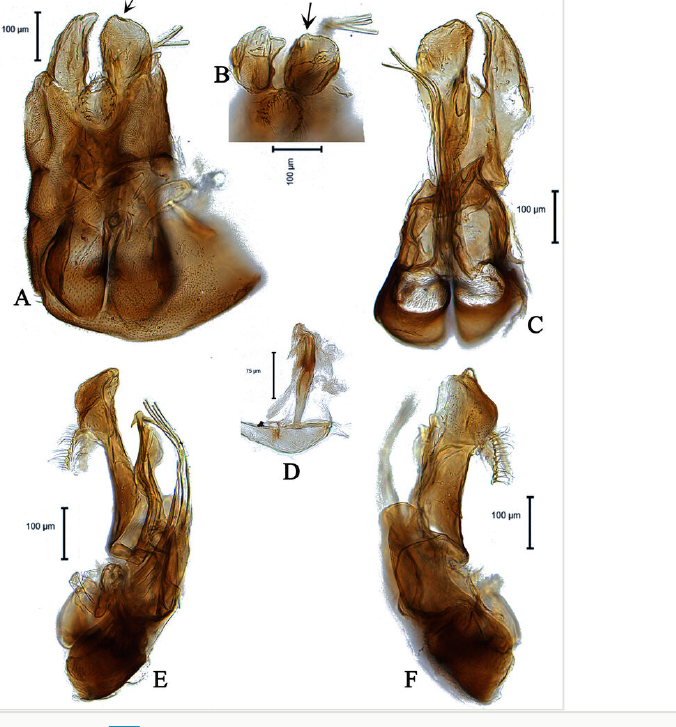
Figure 20. Male genitalia of Eudorylas zermattensis (JSS52162) (A) in dorsal view; (B) surstyli in dorsal view; (C) in ventral view; (D) ejaculatory apodeme; (E, F) in lateral